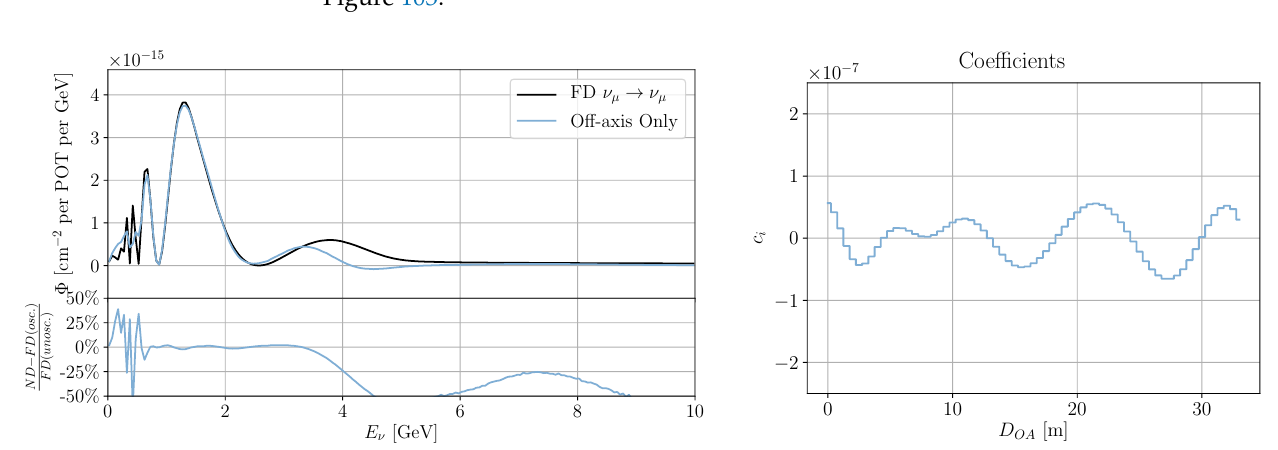
Figure 103. The FD flux and the ND linear combination flux match ( left ) and corresponding coefficients ( right ) are shown using the solution of Equation